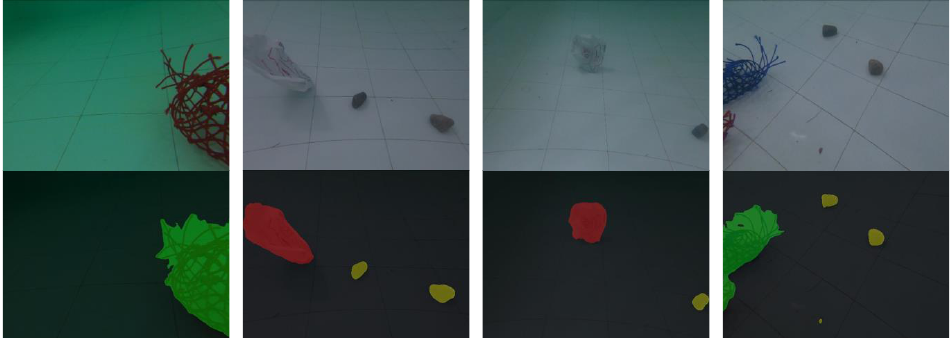
Figure 6. Segmentation results of monocular